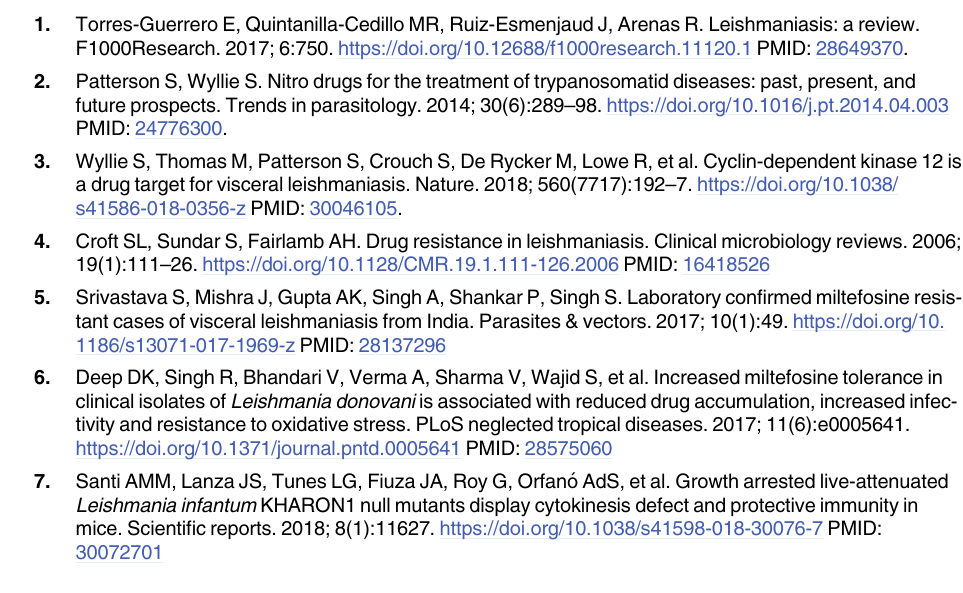
S2 Fig. Quantification of the liver parasite burden reveals no essential role for 54 L . dono- vani genes encoding cell surface and secreted proteins in mammalian host infections. Para- sitemia in groups of five female BALB/c mice that had been challenged with 1 x 10 8 stationary phase gene-targeted L . donovani promastigotes was quantified using bioluminescent imaging at days 0, 3, 8, 16, 22 and 30 days post infection. Separate graphs plot the results from cohorts of mice infected with the indicated mutant parasites. Data points represent means ± s.d.; n =